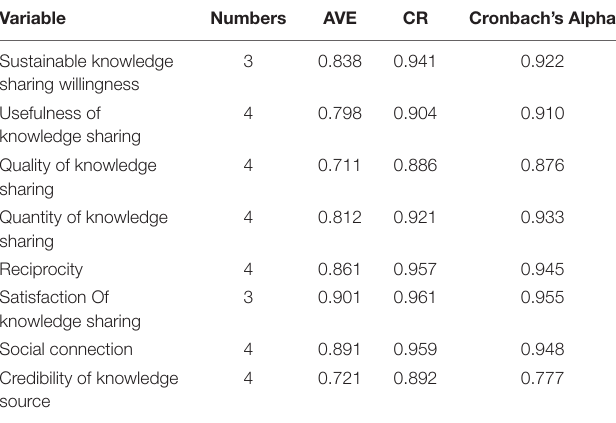
TABLE 1 | Reliability test of the model.